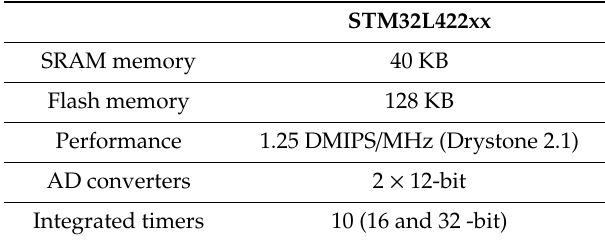
Table 3. ARM Cortex M4 microcontroller